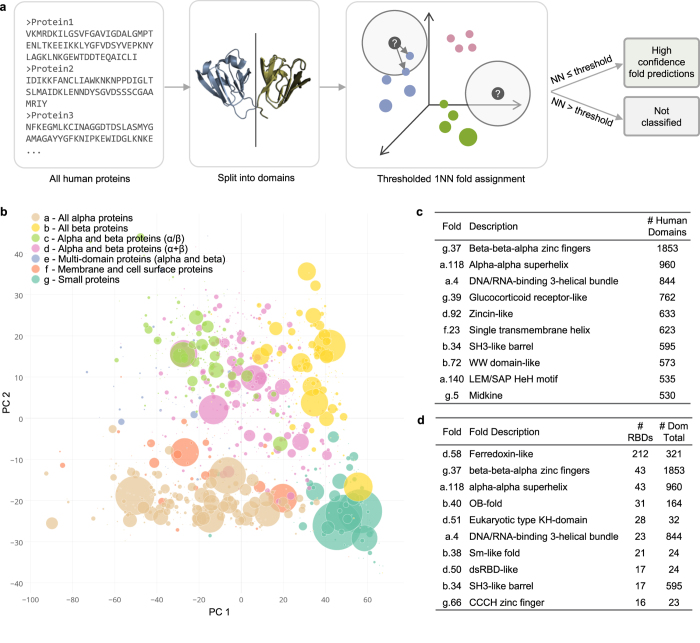
Fold classification of the human proteome.(a) Overview of classification process. Full length human protein sequences were split at predicted domain boundaries to create one or more separate domain sequences per protein (Drew et al. 5). Domain sequences were mapped to the PESS and classified by 1NN classification. A threshold was applied to the nearest neighbor distance (dotted circle), whereby only domains with a nearest neighbor closer than the threshold distance were classified. (b) PCA projection of fold centroids within the PESS, scaled by number of human domains predicted to belong to that fold. Centroids were calculated based on the location of each fold’s training examples within the PESS and are colored by SCOP class. (c) Top ten folds by number of human domain predictions. (d) Top ten likely RNA-binding folds, ranked by number of confirmed RNA-binding domains (RBDs). Confirmed RBDs were determined based on matches to a curated list of RNA-binding related Pfam families.